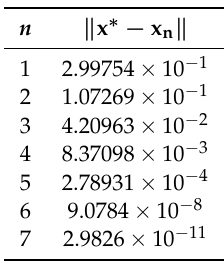
Table 2. Kurchatov method (6).